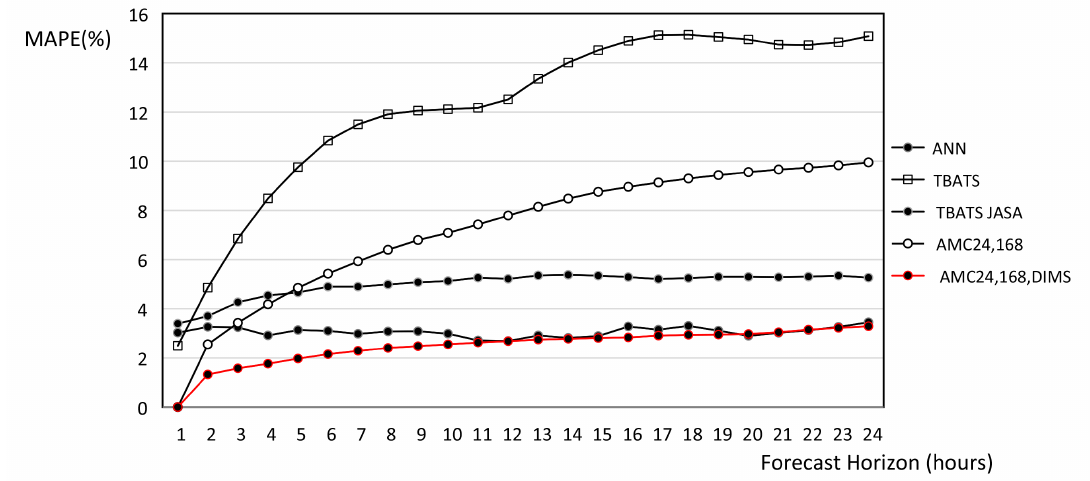
Figure 6. Comparison of MAPE for all methods. ANN is the artificial neural network; TBATS stands for the general Exponential Smoothing State Space Model with Box-Cox Transformation, ARMA Errors, Trend and Seasonal Components (TBATS) method, and TBATS JASA stands for TBATS with regressors. AMC 24,168 is the regular nHWT method, and AMC 24,168, Easter stands for nHWT with